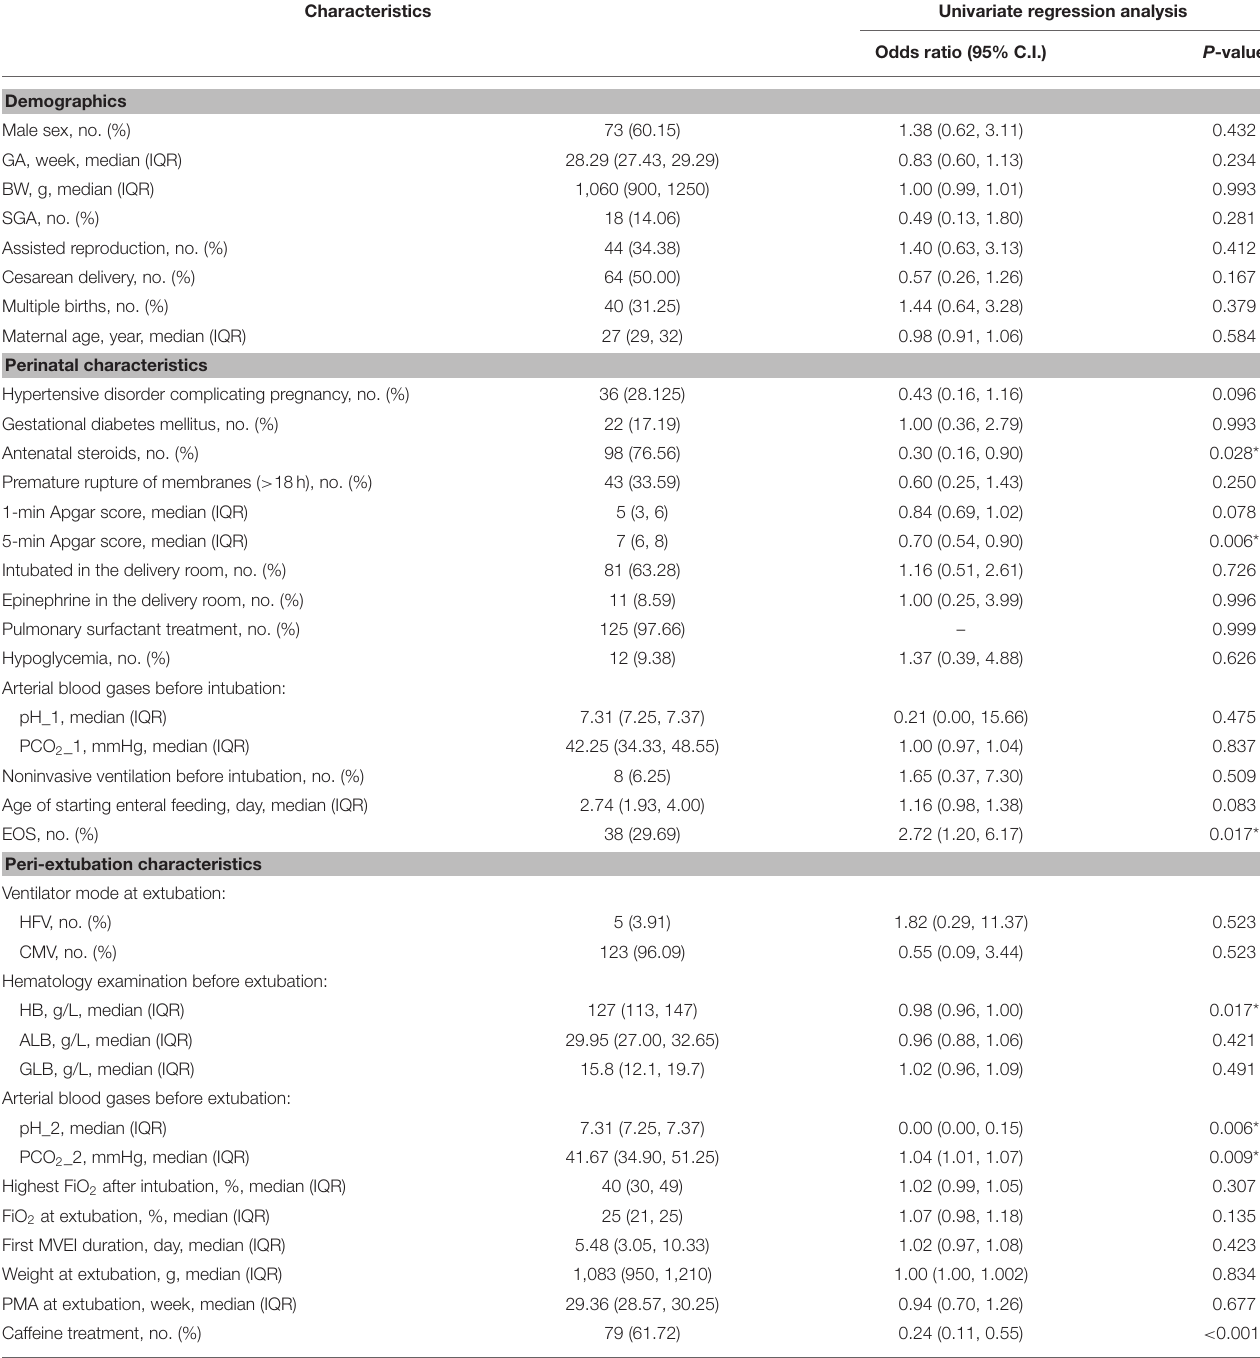
TABLE 1 | Characteristics of 128 preterm infants and Univariate analysis of risk factors for extubation failure. Characteristics Univariate regression analysis Odds ratio (95%